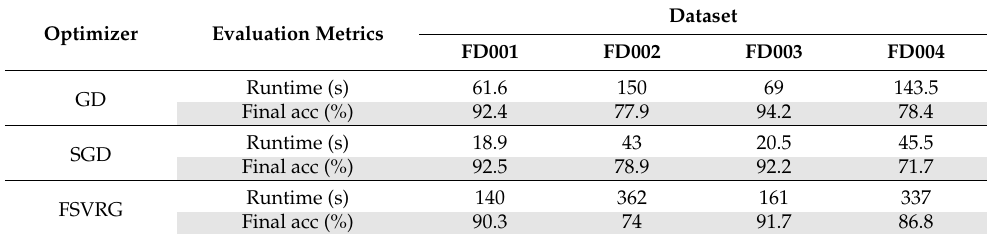
Table 2. Performance analysis of the synchronous FedSVM.